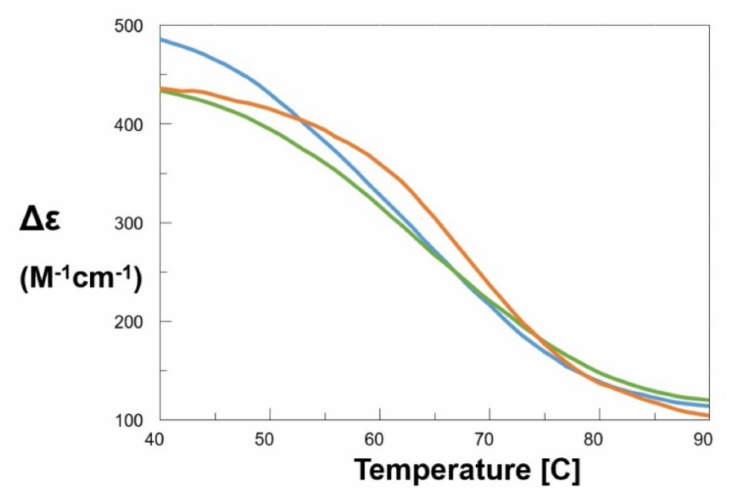
Figure 3. CD denaturation curves of c-myc (green), c-myc+50 equiv. 8-H (azure) and c-myc + 50 equiv. 8,9-di-Cl (orange) in 1x PBS, pH